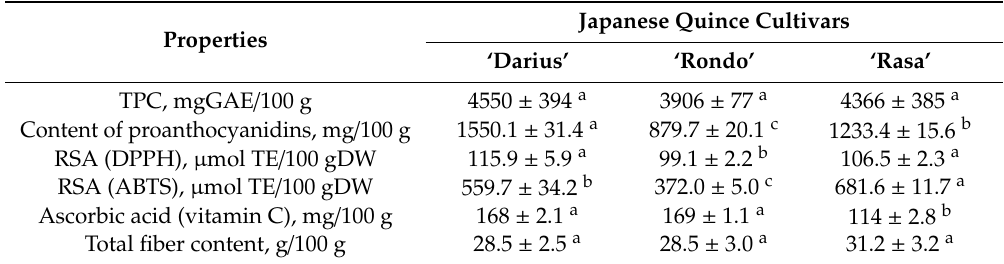
Table 4. The biochemical composition and antiradical activity of Japanese quince fruits.